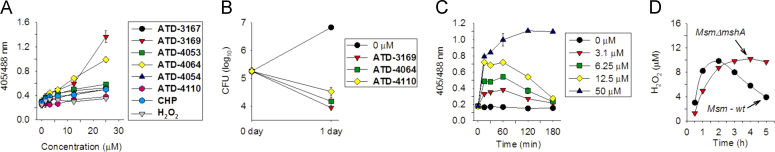
ATD compounds induce an oxidative shift in EMSH of Msm. (A) Msm expressing Mrx1–roGFP2 was treated with various ATD series compounds, H2O2 and CHP (from 1.5–25 μM) for 24 h and the sensor response was measured by flow cytometry by exciting at 405 and 488 nm lasers and constant emission at 510 nm. (B) Msm was grown to an OD600 nm of 0.6, diluted to an OD600 nm of 0.06 and treated with ATD-3169 (50 µM), ATD-4064 (200 µM), ATD-4110 (200 µM) for 24 h. CFUs were plated at 0 and 24 h on 7H11 solid media supplemented with ADS. (C) Msm expressing Mrx1–roGFP2 was treated with nonlethal (3.1, 6.25, 12.5 μM) and lethal (50 µM) concentrations of ATD-3169, and the sensor response was measured by flow cytometry at various time points. Error bars represent standard deviations from the mean. Data shown are the representative of at least three different experiments performed in triplicate. (D) The time course of H2O2 generated during incubation of Wt-Msm and MsmΔmshA strains with 10 µM of the ATD-3169 compound in pH 7.4 was estimated using an Amplex Red fluorescence assay.